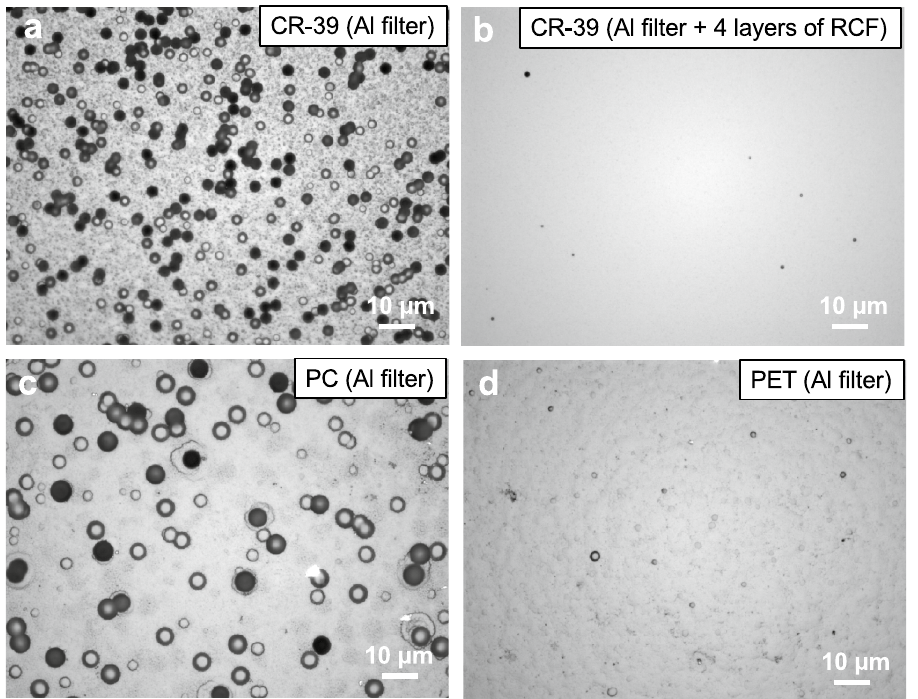
Figure 2. Microscope images of etch pits registered on the front surface of the first layer of ( a ), ( b ) CR-39, ( c ) PC, and ( d ) PET. ( a ) The smaller (less than 1 μm in radius) and the larger (around 2 μm in radius) etch pits correspond to protons and carbon/oxygen ions, respectively. Note that the smaller etch pits were overlapped each other. ( c ), ( d ) Surface of each SSNTD is rough because of chemical damage during